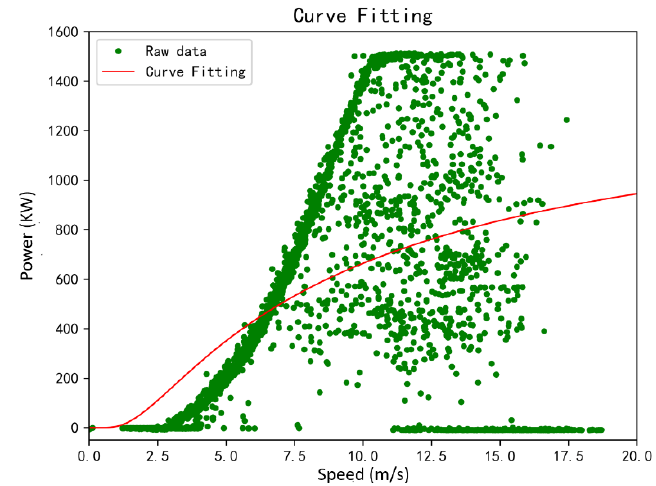
Figure 7. SCADA wind speed and power data fitting diagram for a sample wind turbine. The power curve is shown in red. The green dots are 15 ‐ min mean wind speed and wind power pairs. The data period is 1 January 2019 to 31 December 2019.